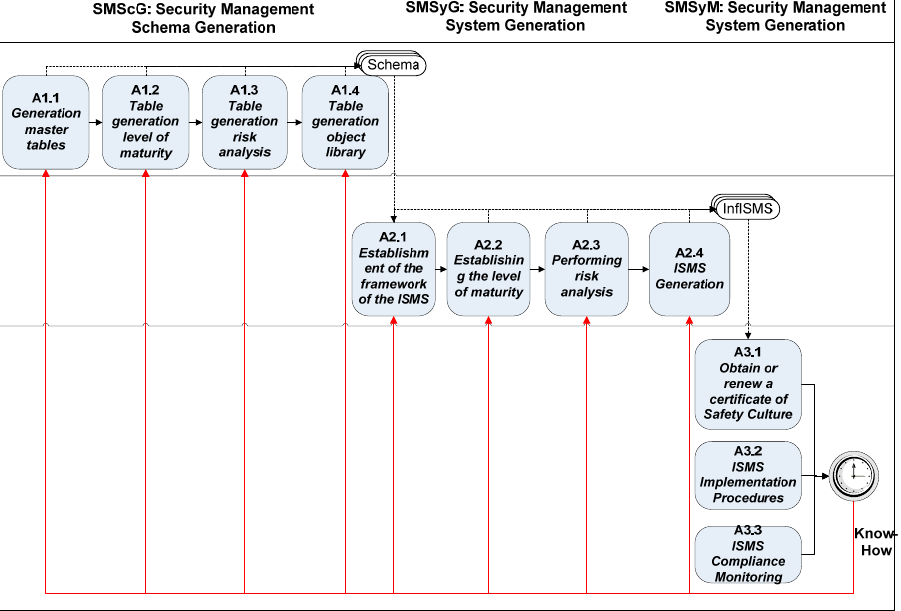
Figure 2. Sub ‐ processes of the methodology. Figure 2. Sub-processes of the